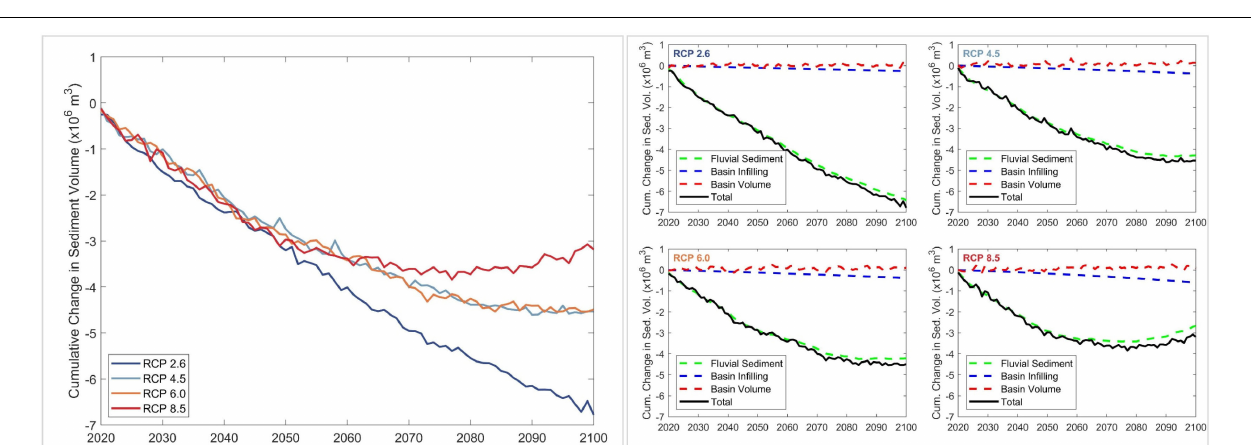
FIGURE 9 | Projected change in total sediment volume exchange ( (cid:49) V T ) between the Kalutara estuary and the adjacent coast (left) , and the relative contributions of the three different sediment volume components (right) over the 21 st century for RCP 2.6, 4.5, 6.0, and 8.5. Negative and positive values of (cid:49) V T indicate sediment imported to the estuary from the adjacent coast and sediment exported from the estuary to the adjacent coast,